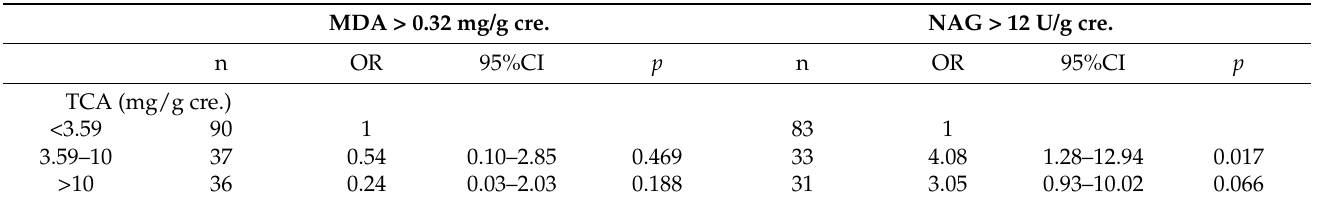
Table 4. Urinary TCA levels correlated with levels of MDA and NAG using multiple logistic regression adjusted for gender and